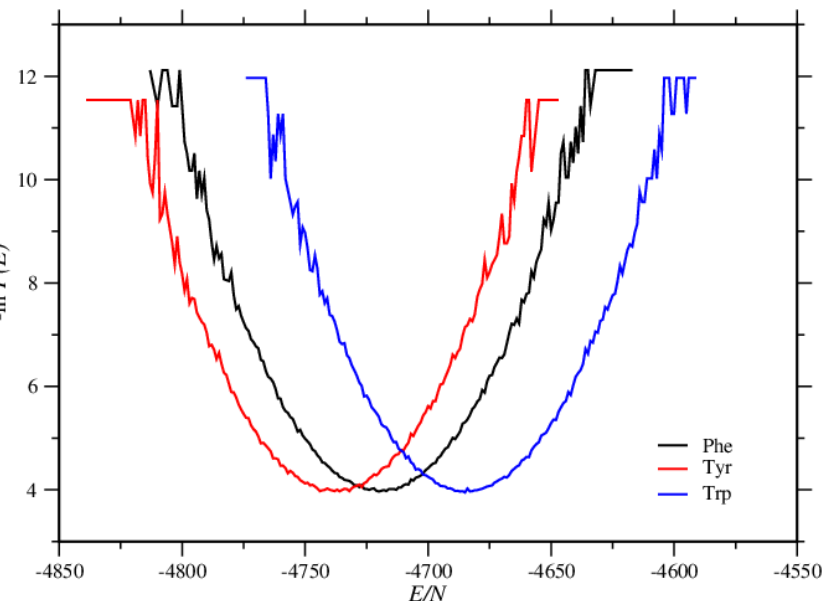
Figure 11. Energy distribution functions for the simulations of Phe, Tyr, and Trp molecules, N = 27 is the number of molecules in the systems.